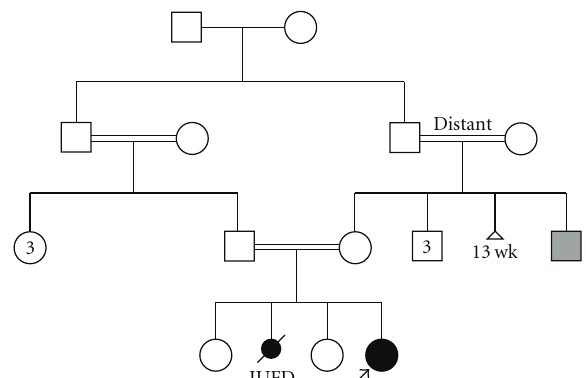
Figure 1: The family pedigree.